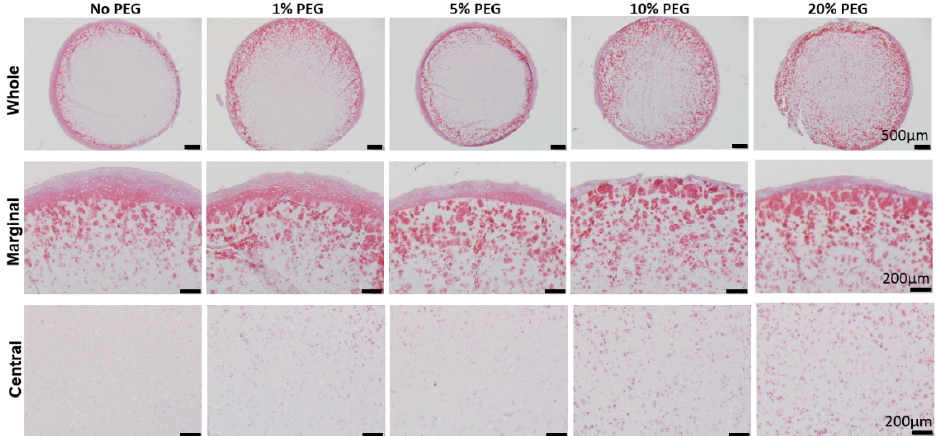
Figure 4. Safranin O staining to assess GAG deposition in different groups. 1–20% ( w / v ) indicated the concentration of uncured PEG solution that GH was dipped into. Bar = 500 μ m in the top panel and 200 μ m in the middle and bottom panels.